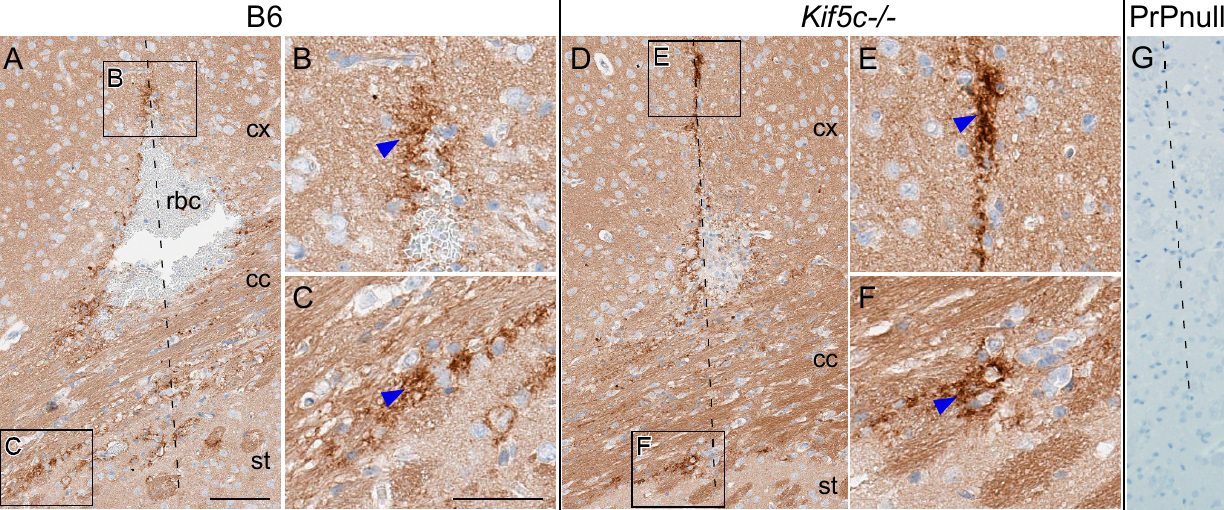
Figure 1. PrPSc staining of 22 L scrapie 7 days post-inoculation. IHC using anti-PrP antibody D13 was performed on coronal sections containing the needle track (nt) from B6 mice (left) and Kif5c − / − mice (middle) and PrP null mice (right). ( A , D ) Overviews of the cerebral cortex (cx), corpus callosum (cc) and dorsal aspect of the striatum (st). The nt is shown with a dashed line, red blood cells (rbc) can be seen in A from hemorrhage post inoculation. ( B , C , E , F ) Higher magnification of the cx, cc and st showing PrPSc closely associated with the nt (blue arrowheads). Similar staining was observed in B6 and Kif5c − / − mice. ( G ) No cellular prion protein (PrPC) staining is present with D13 IHC on PrP null mouse brain tissue, 7 days post-inoculation. The scale bar in A is 100 µ m and applies to panels A,D and G, the bar in C is 50 µ m and applies to panels B, C, E and